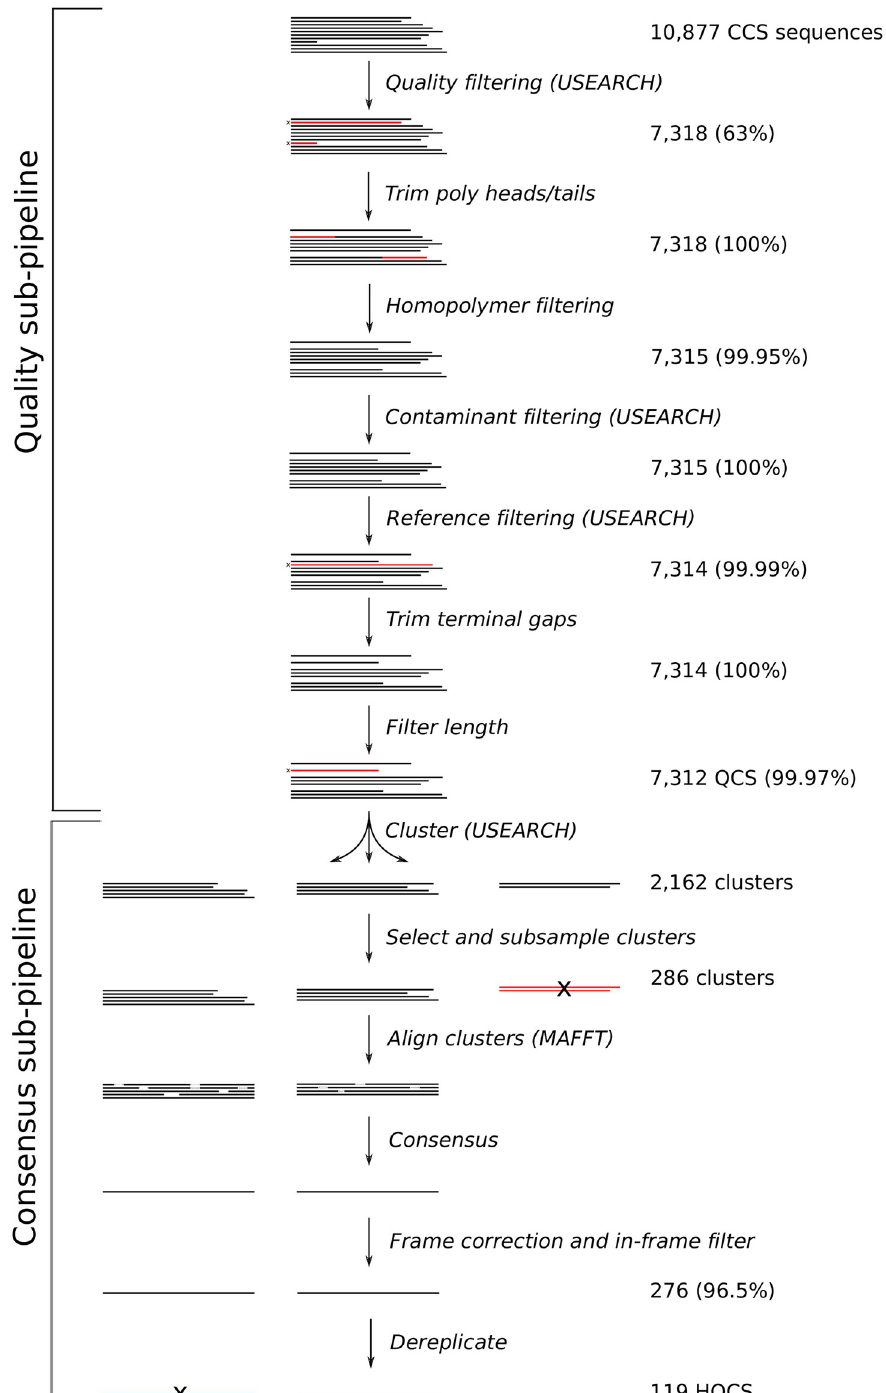
Fig 2. Quality and consensus sub-pipelines. These steps are repeated independently on each time point. Numbers are reported from the analysis of sequences from the first time point (V03) of donor P018, which is three months post infection. Percentages give the fraction of sequences retained after filtering. Tasks indicate whether they use third-party tools USEARCH or MAFFT .